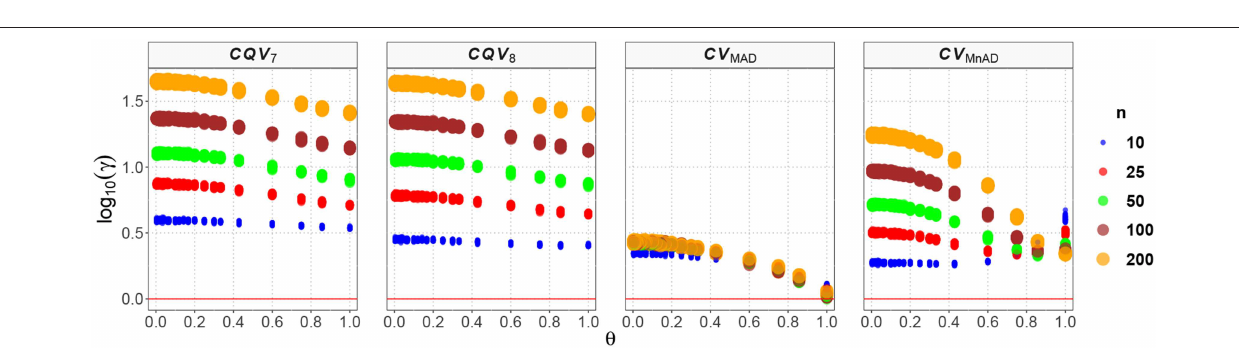
FIGURE 11 | Scatter plots comparing the log 10 ( γ ) accuracy metric as a function of θ Gamma distribution.